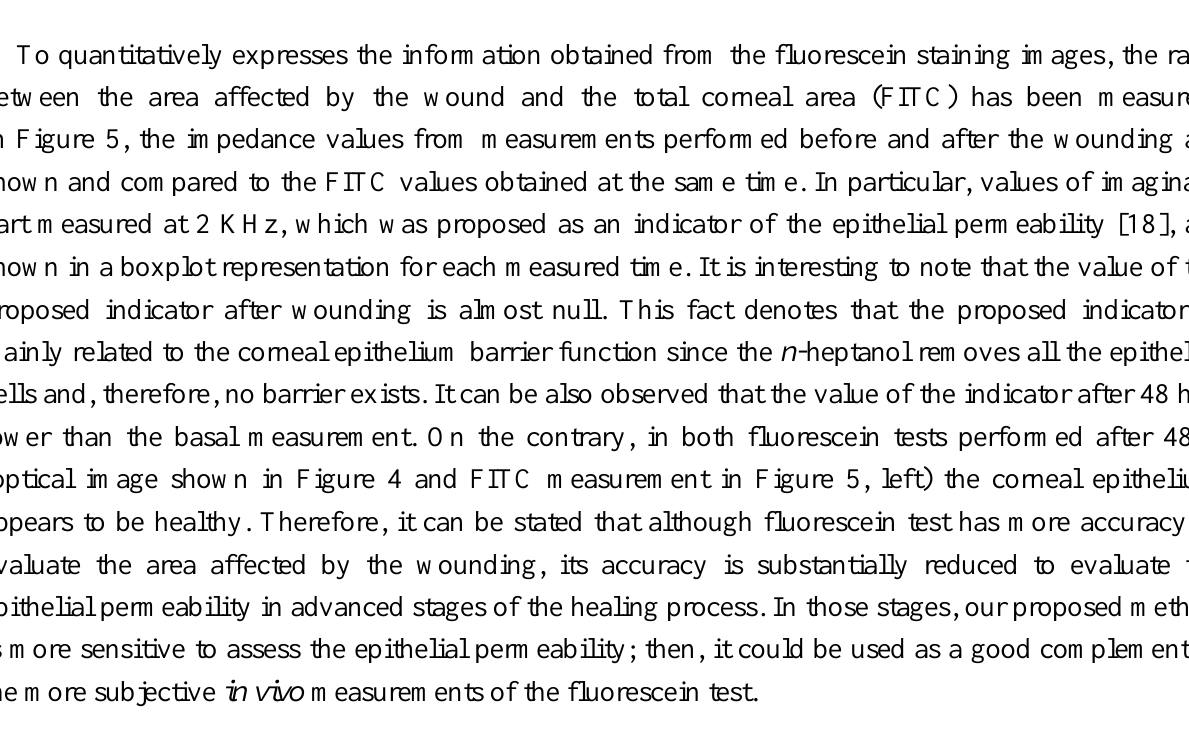
Figure 5. Boxplot representations of the measured wound affected area (FITC) ( left ) and the value of the imaginary part of the impedance measure at 2 kHz ( right ). Measurements have been performed on the same eye, before wounding (basal) and after 15 min, 6 h, 24 h, 48 h, 72 h and 96